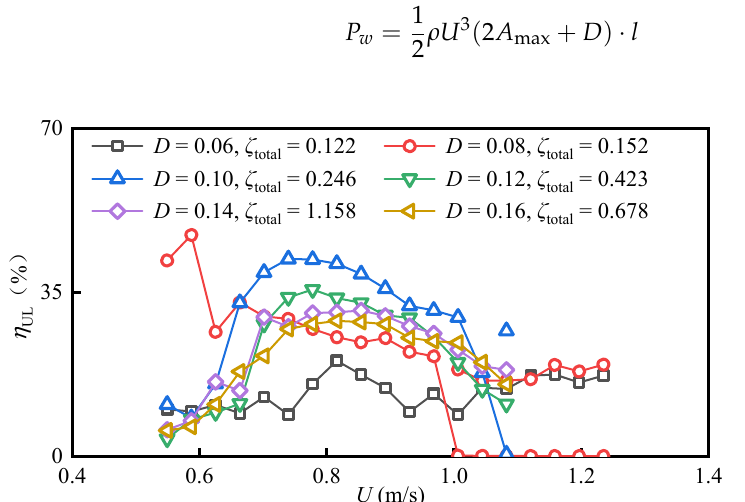
Figure 20. Variation of maximum power output e ffi ciency versus velocity at various Re.